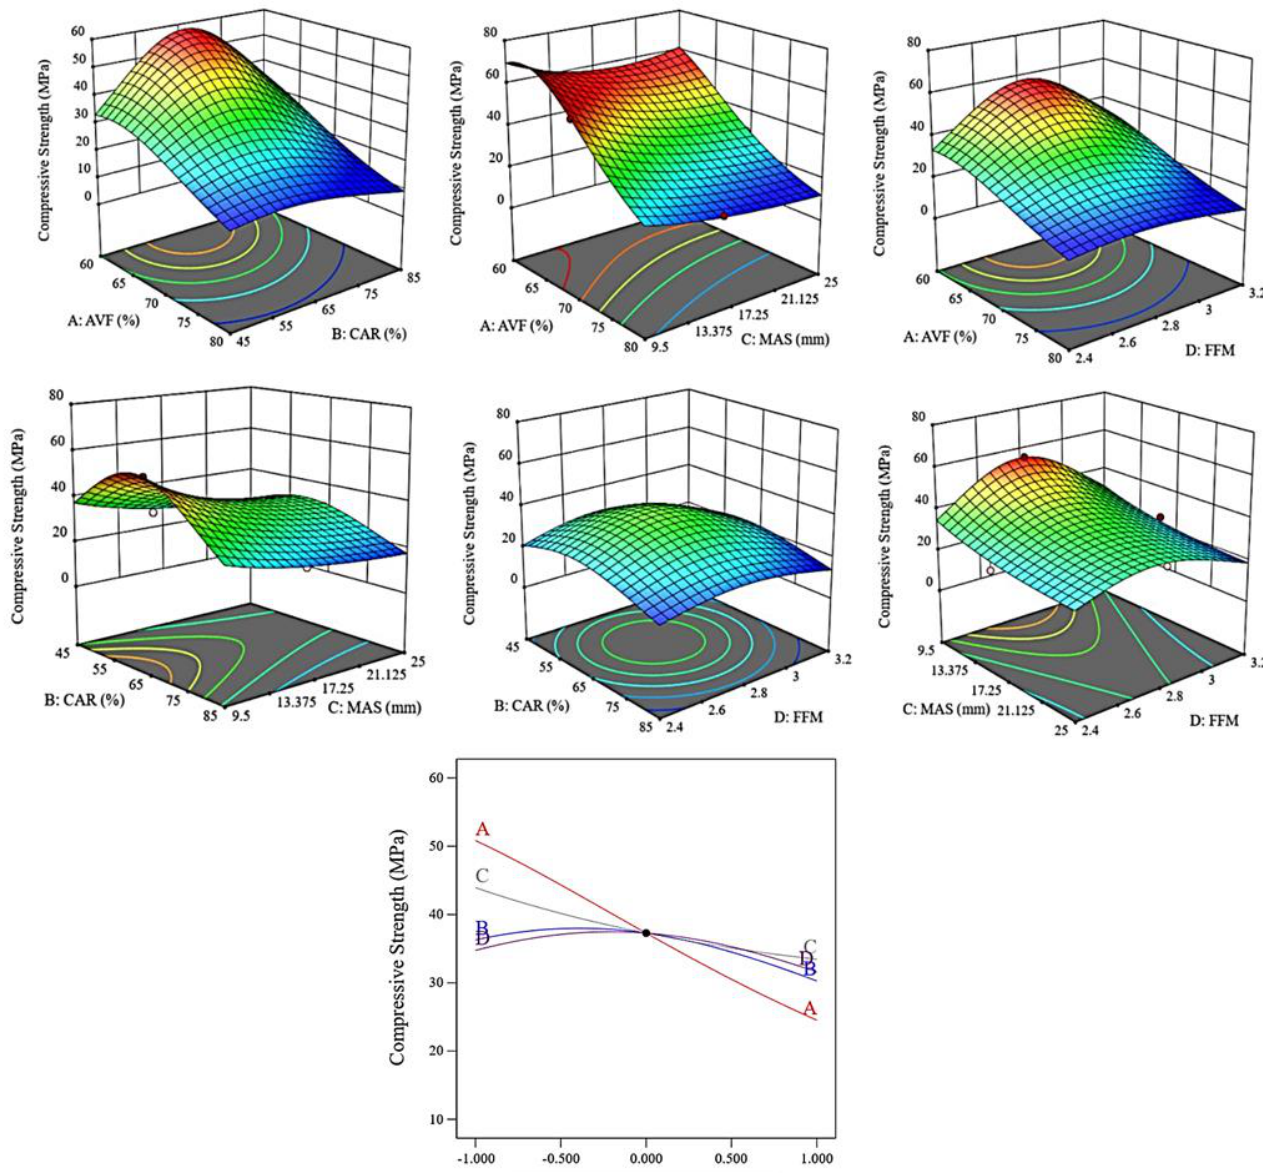
Figure 12. Response surfaces and perturbation plot of the compressive strength model.